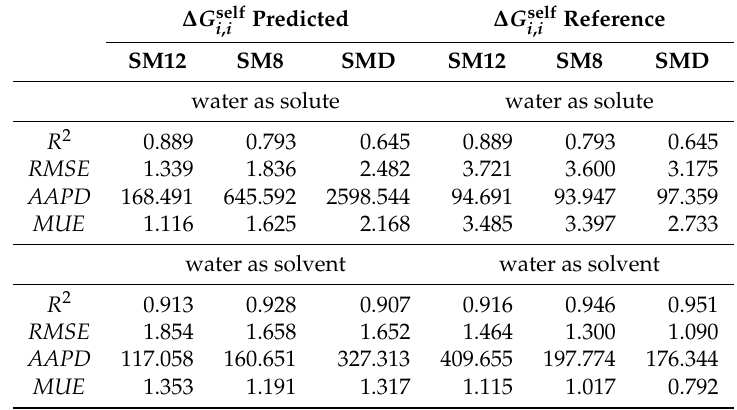
Table 5. A summary of the squared correlation coefficient ( R 2 ), root mean square error ( RMSE ), and mean unsigned error ( MUE ) for ln γ ∞ , and the average absolute percent deviation ( AAPD ) for γ ∞ i , j i , j predicted using the SM12, SM8, and SMD universal solvent model as compared to the reference data from “Yaws’ Handbook of Properties for Aqueous Systems” [56]. For the predictions, we compare